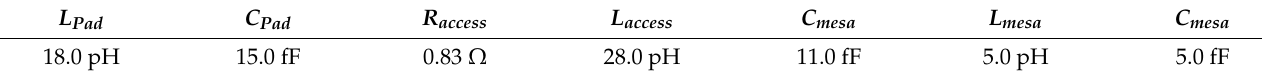
Table 2. Extracted values of the lumped electrical elements, equivalent to the pads and access lines for the InGaAs/InGaAsP UTC-PDs.